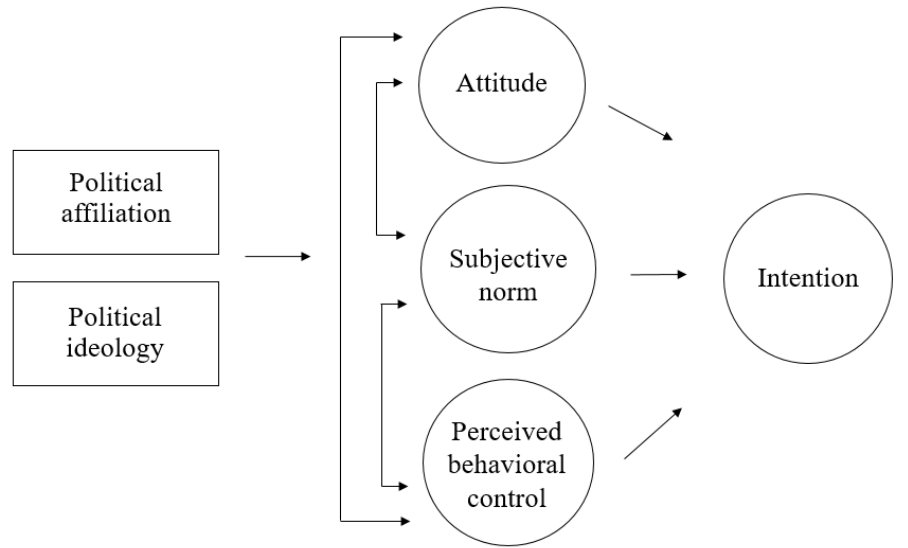
Figure 2. TPB with Political Affiliation and Ideology (Adapted from Ajzen, 1991).